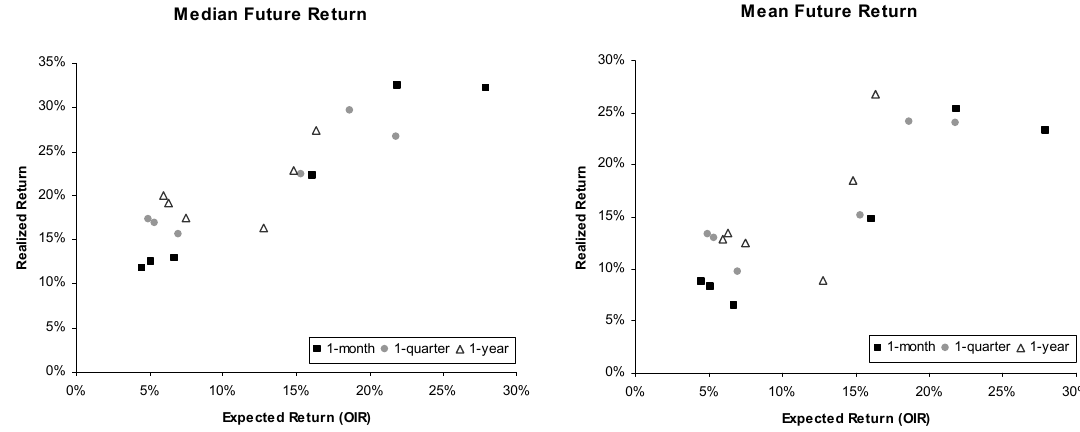
Figure 2. Relation between the expected return (OIR) and realized return over various horizons.